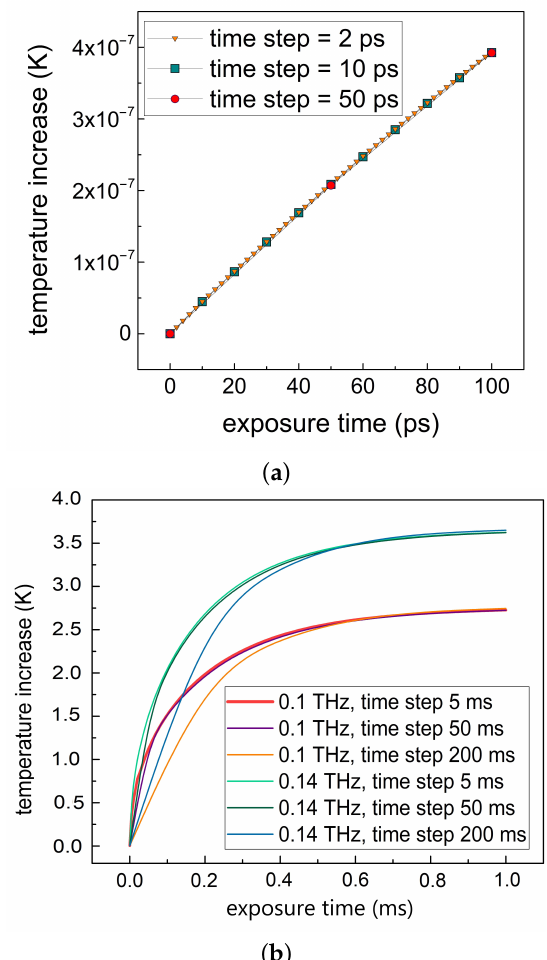
Figure 6. Temporal temperature increase in the film under the exposure calculated with different solver time steps. ( a ) the variations of small time steps at initial exposure times (example of 0.14 THz). ( b ) the variations of higher time steps at longer exposure times. The results are given for PM substrate with κ = 1 W/(m ·